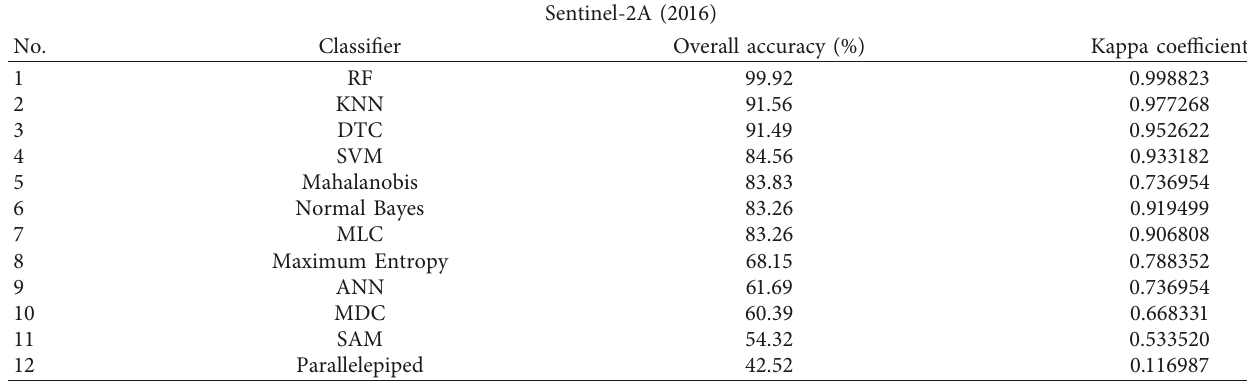
Table 6: Overall accuracy and kappa coefficient with Sentinel-2A satellite.